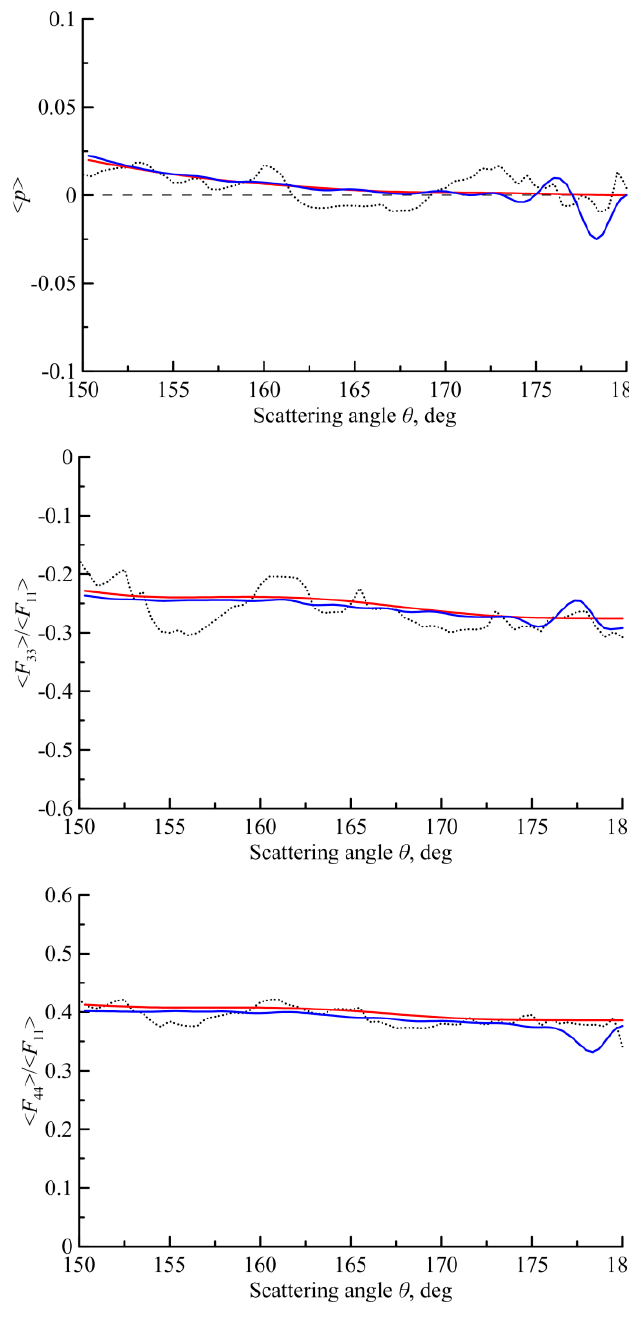
Figure 4. The scattering matrix for the shape 3 of Figure 1.